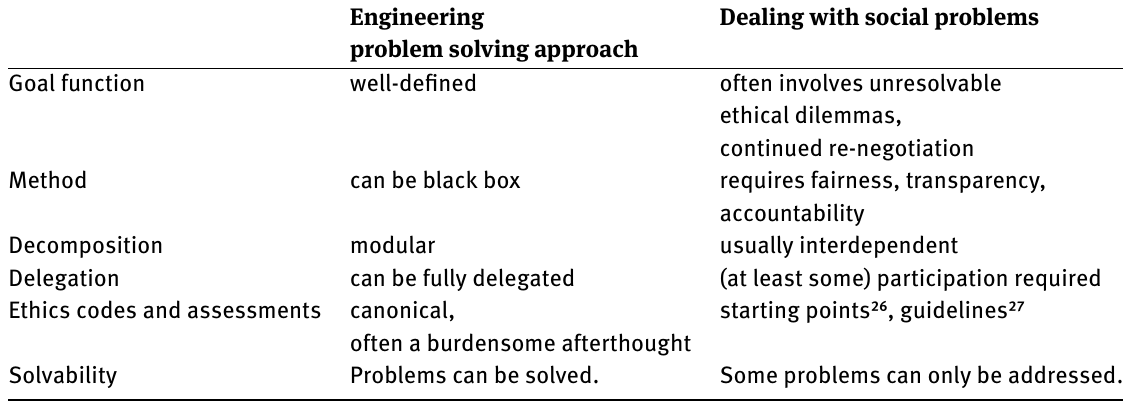
Table 1: Solving engineering problems vs. dealing with social problems.